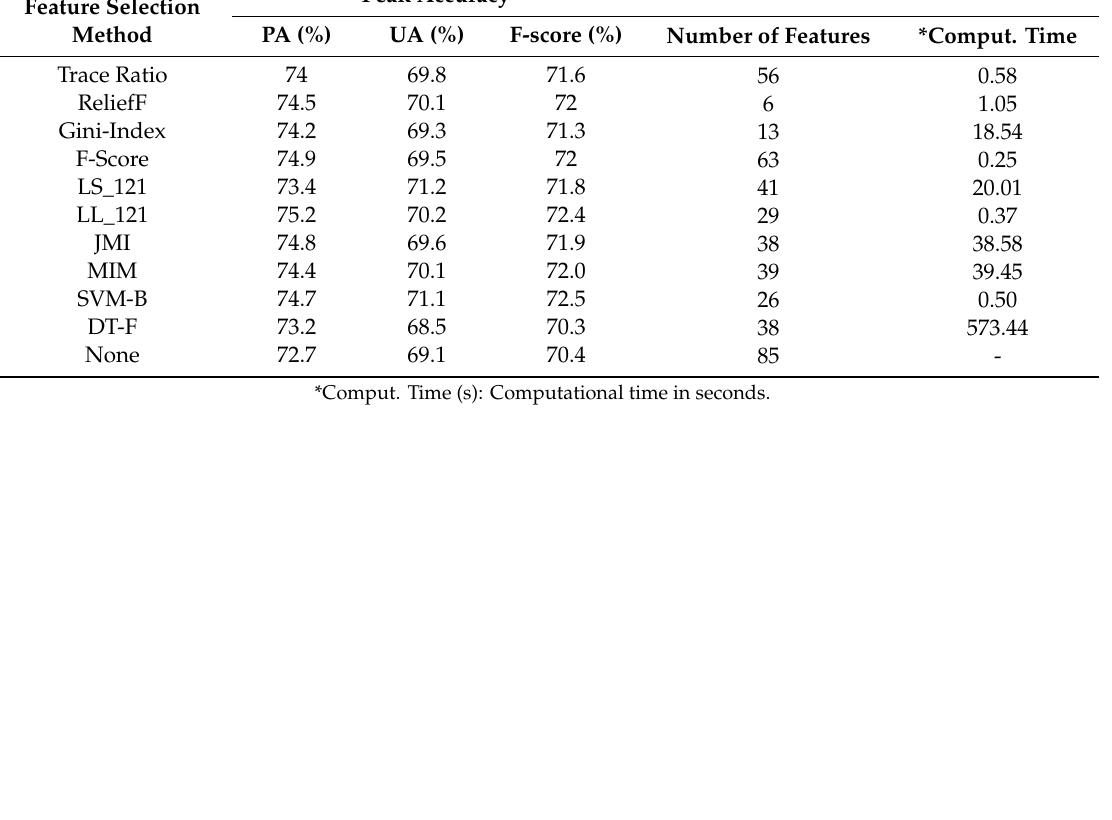
Table 2. F-score, PA and UA of Parthenium weed using optimal feature subsets yielded by investigated feature selection methods for first training set.